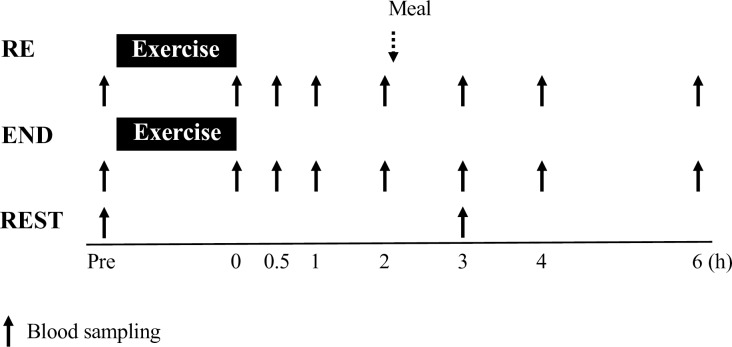
Experimental schedule, indicating the timing of measurements.